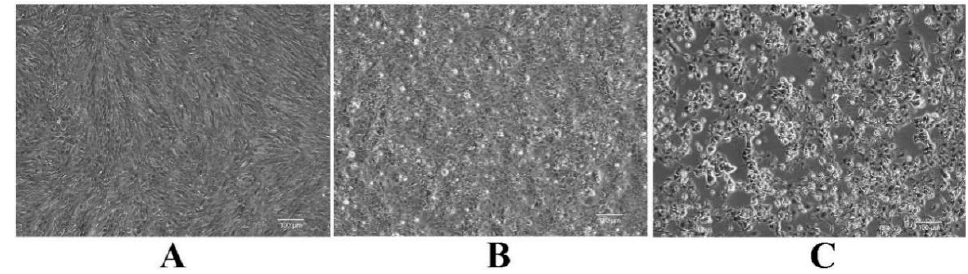
Figure 4. The CPE of Micropterus salmoides heart (MSH) cells infected with new isolated virus in MSH cell monolayers. ( A ) Uninfected MSH cells, ( B ) MSH cells at 1 day post-infection (dpi) with the new isolated virus, and ( C ) MSH cells at 5 dpi with the new isolated virus. Bar = 100 µm.